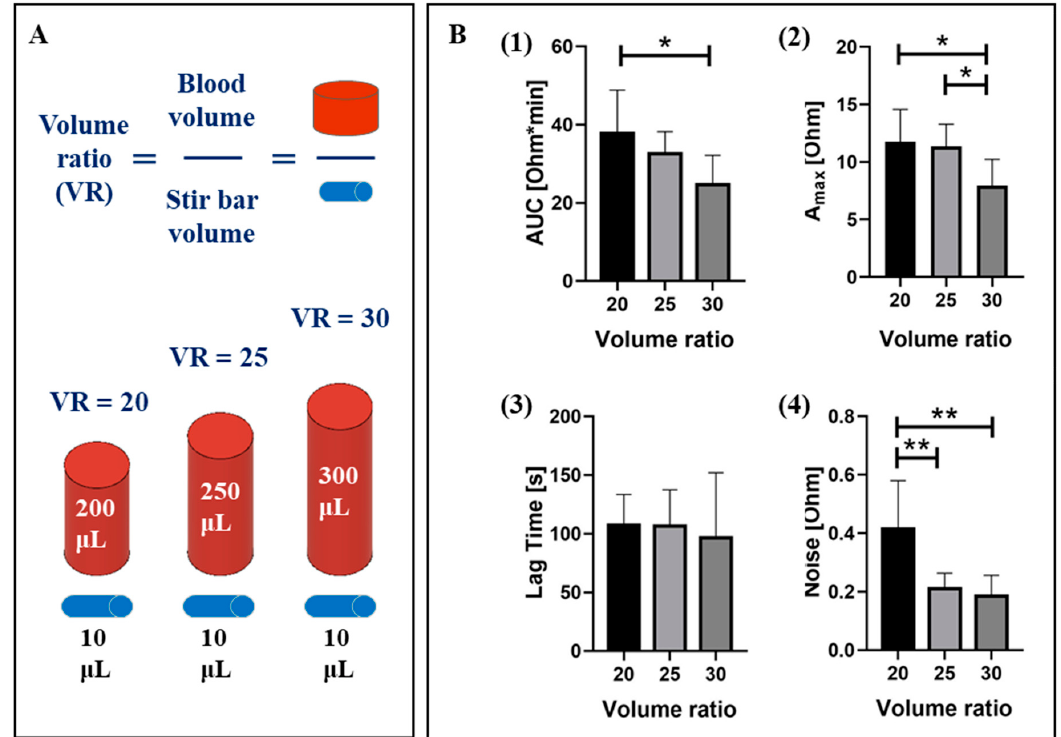
Figure 1. The effect of the sample to stir bar volume ratio (VR) on aggregation parameters collected by the MICELI (microfluidic, electrical, impedance) system: ( A ) calculation of VR for three sample volume tested, i.e., 200, 250, and 300 μ L, and siliconized stir bar (#311, Chrono-log Corporation, Havertown, PA); ( B ) the effect of different VRs on ADP-induced platelet aggregation in ACD-anticoagulated whole blood: 1—area under the curve (AUC), 2—maximum aggregation (Amax), 3—lag time, and 4—noise, i.e., the amplitude of the impedance fluctuation over assay time. Data from 4 independent experiments using blood sample from 4 different individuals are reported. Mean ± SD as error bars of aggregation parameters are indicated, ANOVA: * p < 0.05, ** p < 0.01.